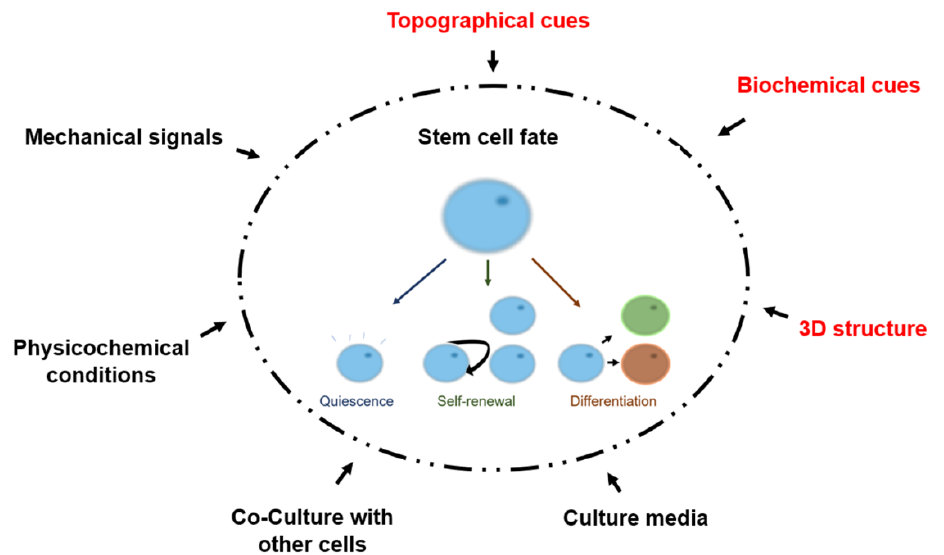
Figure 2. Schematic representation of environmental factors that affect stem cell fate. The factors highlighted in red are discussed in this review. Mechanical signals although intrinsically related to spatial distribution and topography are not covered in this review. Adapted with permission from ref. [15]. Copyright 2003. Copyright Jiang and Papoutsakis’s Name.